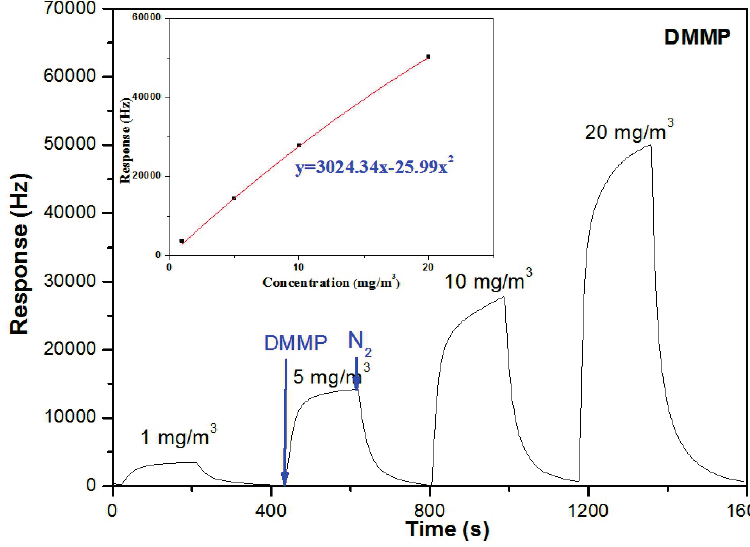
Figure 2. Real-time responses of the PLF sensor to DMMP at concentrations ranging from 1 to 20 mg/m 3 (3 min DMMP and 3 min N 2